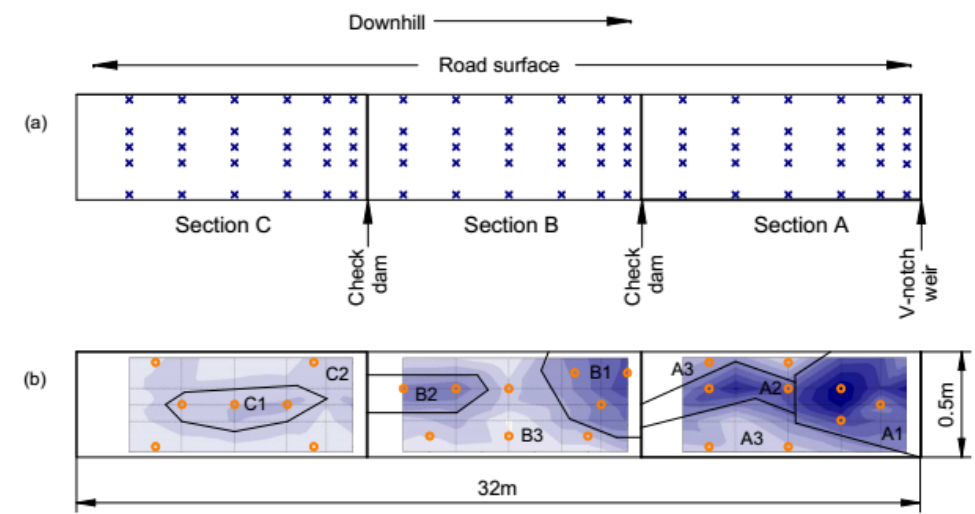
Figure 2. Schematic of ( a ) surface soil sampling and ( b ) core sampling of the biofiltration swale in Compans. Surface samples were taken at each blue x (a), while cores were taken at each orange circle and mixed according to zones (A1, A2, A3, B1, B2, B3 and C1, C2) selected based on the cartography of copper concentrations shown in the background ( b ). Please note that horizontal and vertical scales are different.